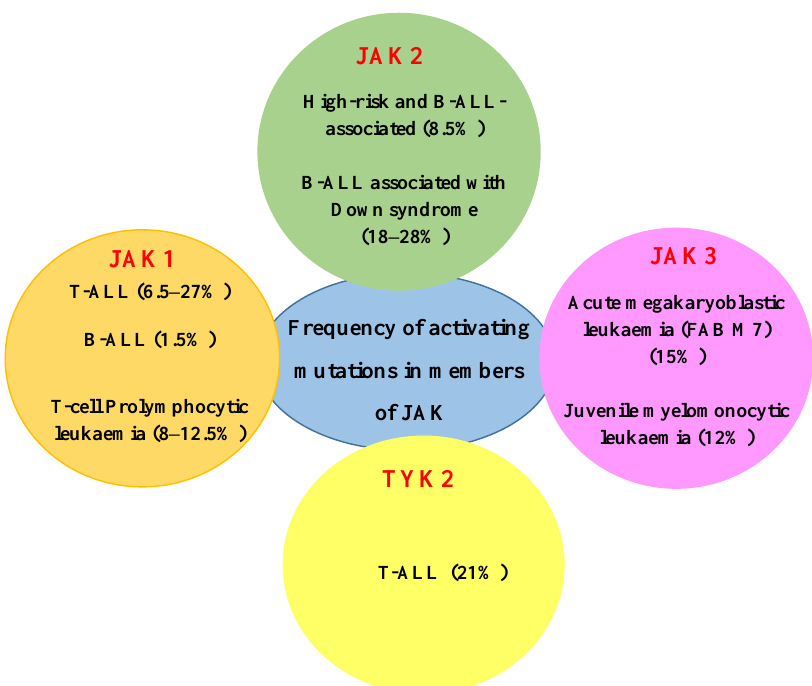
Figure 3. Frequency of activating mutations in members of JAK among different haematological malignancies